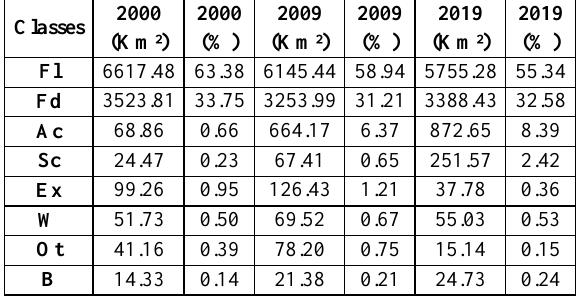
Table 5. Changes in the land use and land cover changes in the Chapadinha